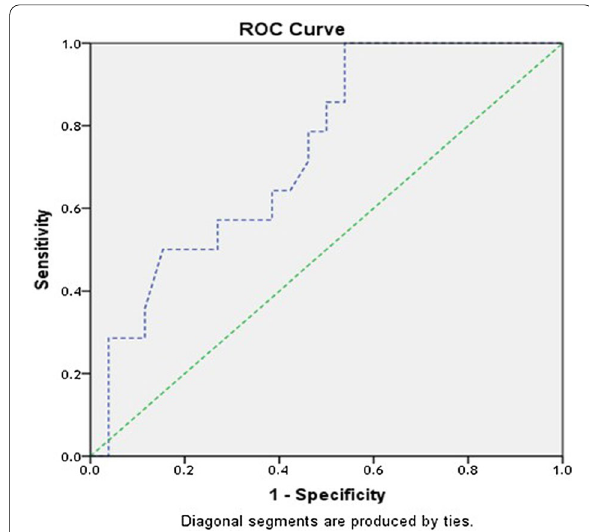
Fig. 2 Receiver operating characteristics (ROC) curve for prediction of unstable angina or acute myocardial infarction. Significant area under the curve (0.738, p 0.014) with cutoff of < 0.66 ng/mL, = sensitivity 64.3%, specificity